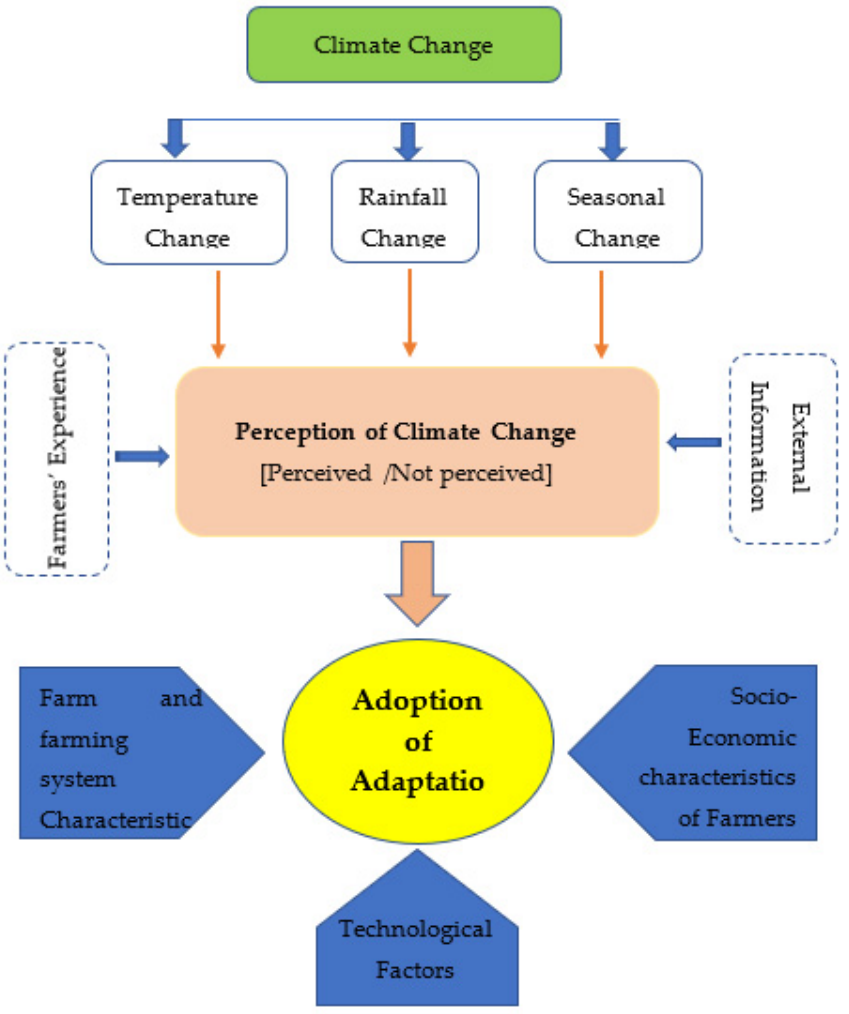
Figure 2. Research framework for climate change perception and adoption.